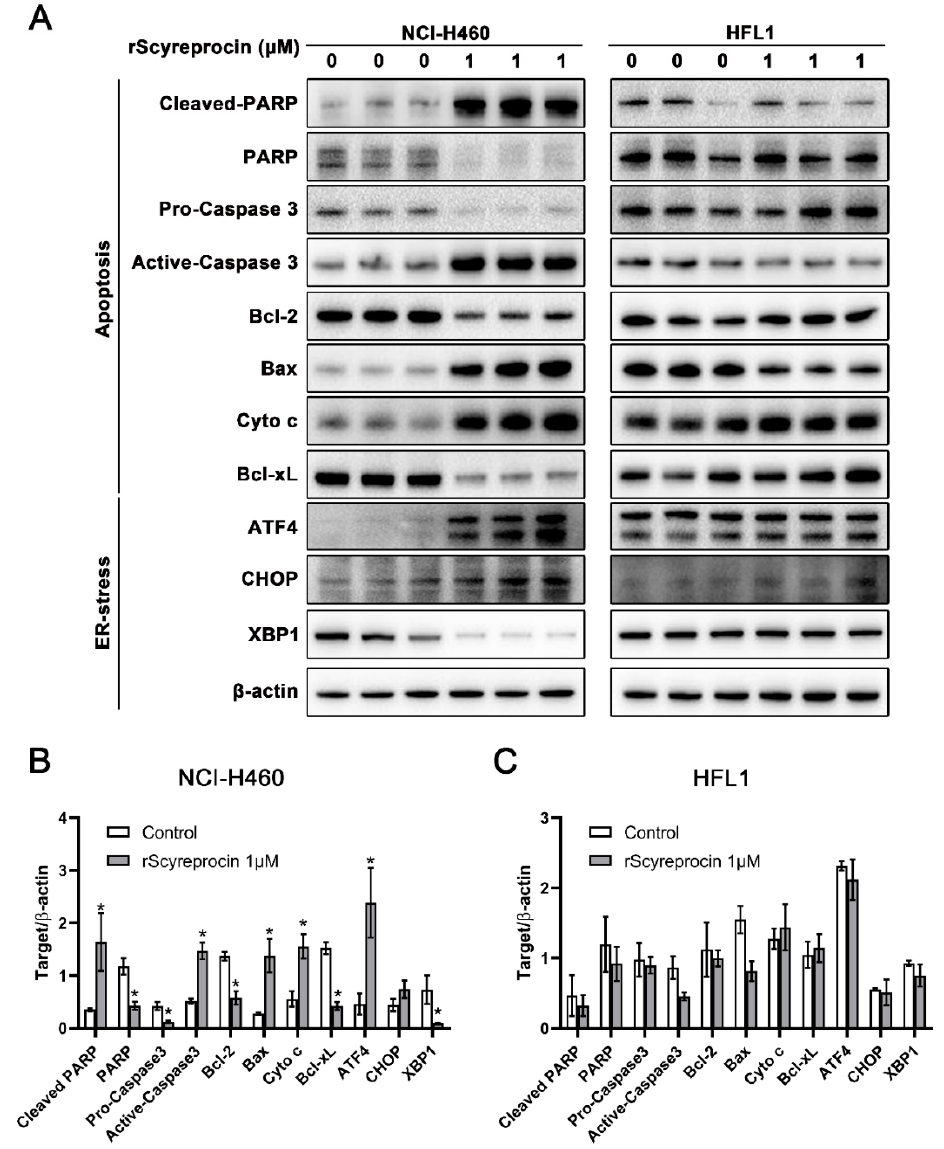
Figure 5. Recombinant scyreprocin (rScyreprocin) induced changes in expression levels of key proteins in pathways associated with apoptosis and ER stress. H460 and HFL1 cells were treated with rScyreprocin (0 and 1 μ M) for 24 h. Levels of apoptosis-related and ER stress-related proteins in whole cell lysate ( n = 3) were determined by Western blotting ( A ). Data were quantified using Image J Software and are presented in ( B , C ). Data are presented in means ± standard deviation (SD). In ( B , C ), data were normalized to the value of β -actin and analyzed by Student’s t -tests. (* p < 0.05). BAPTA (1,2-bis (2-aminophenoxy) ethane-N,N,N ′ ,N ′ -tetraacetic acid tetrakis) is a cal- cium-selective chelator, and N-acetylcysteine (NAC) is an inhibitor of reactive oxygen species (ROS). Pretreatment of BAPTA and NAC could inhibit the increase of intracellular Ca 2+ and ROS concentration, respectively.